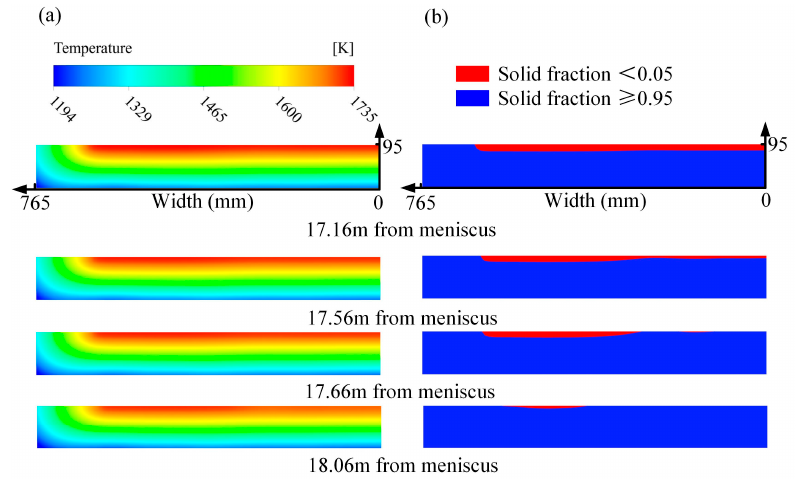
Figure 8. ( a ) Temperature field and ( b ) solidification profile in transverse sections with different distances from the meniscus.